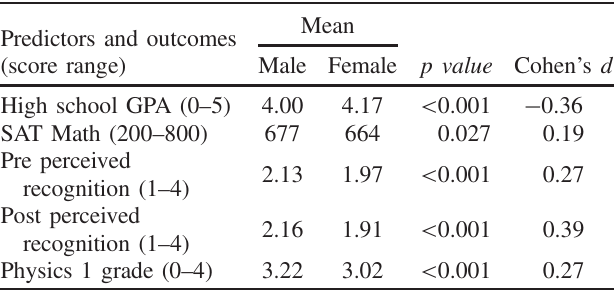
TABLE II. Mean predictor and outcome values by gender as well as statistical significance ( p values) and effect sizes (Cohen ’ s d ) by gender.